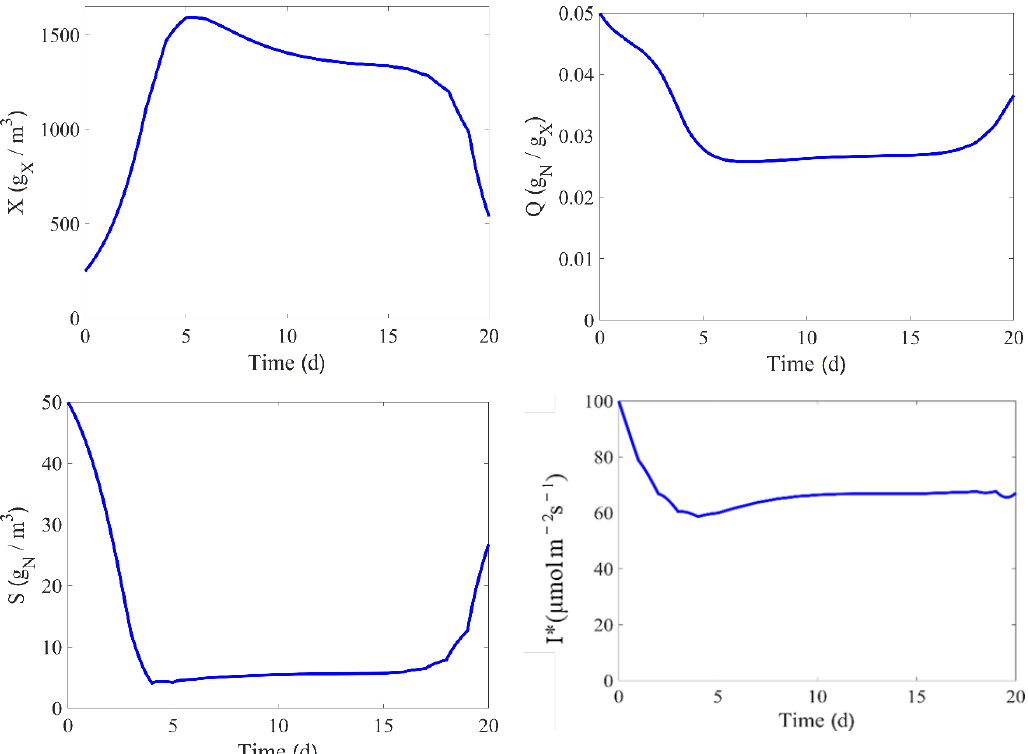
Figure 6. State variables simulation results from the identified model with NMPC manipulating photon flux density ( I 0 ) and dilution rate ( D ).